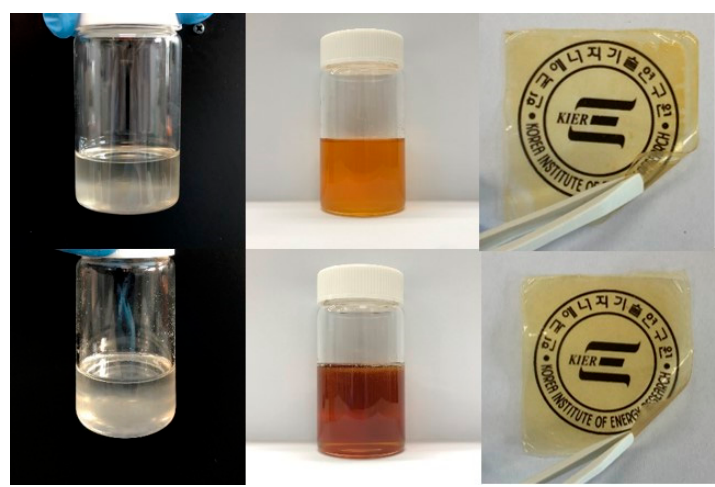
Figure 2. Photographic images of the Nafion-TMA (trimethyl amine, upper) and Aquivion-TMA (lower)-based dispersions in N , N -dimethylformamide (DMF, left ) and N -methyl-2-pyrrolidone (NMP, middle ), and the resulting membranes ( right ).